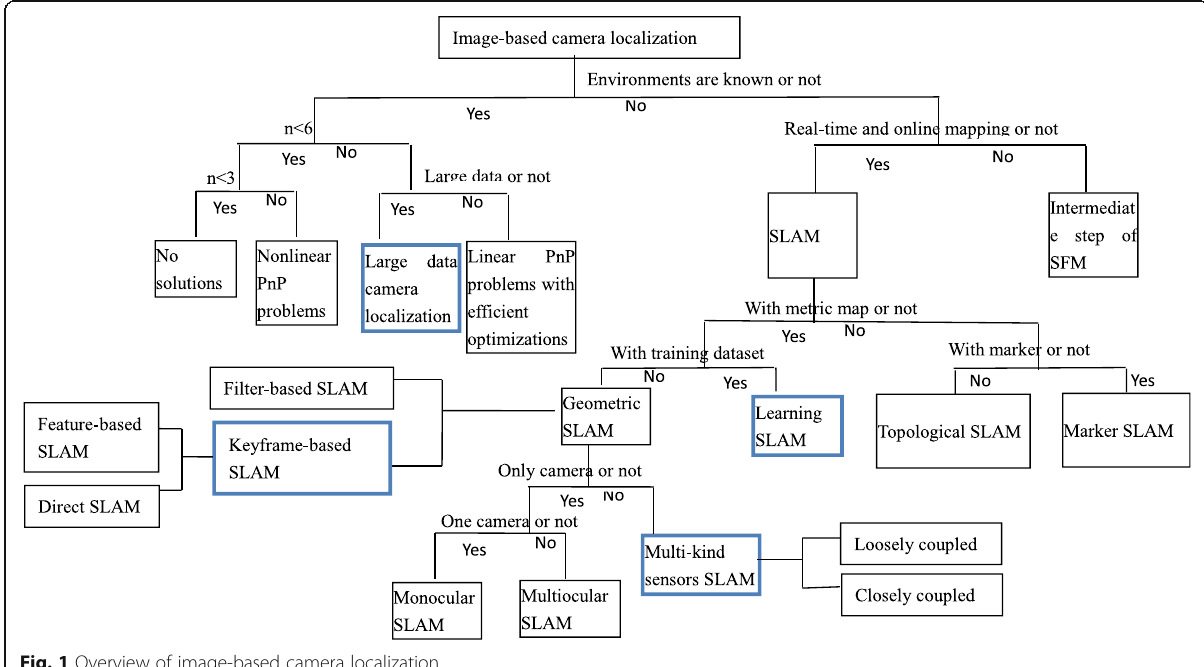
Fig. 1 Overview of image-based camera